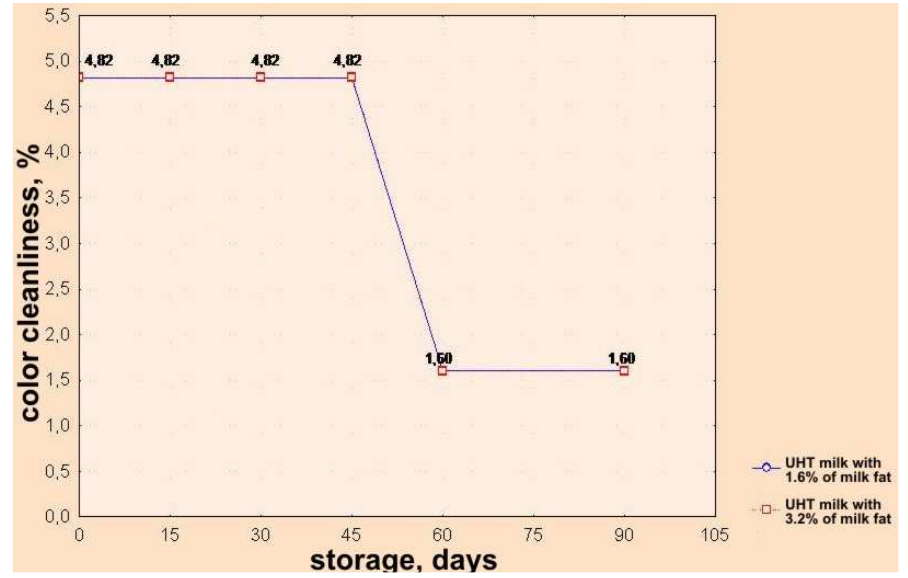
Figure 4 . Effects of storage time on changes of color purity of UHT milk samples with 1.6% and 3.2% milk fat represented in the CIE